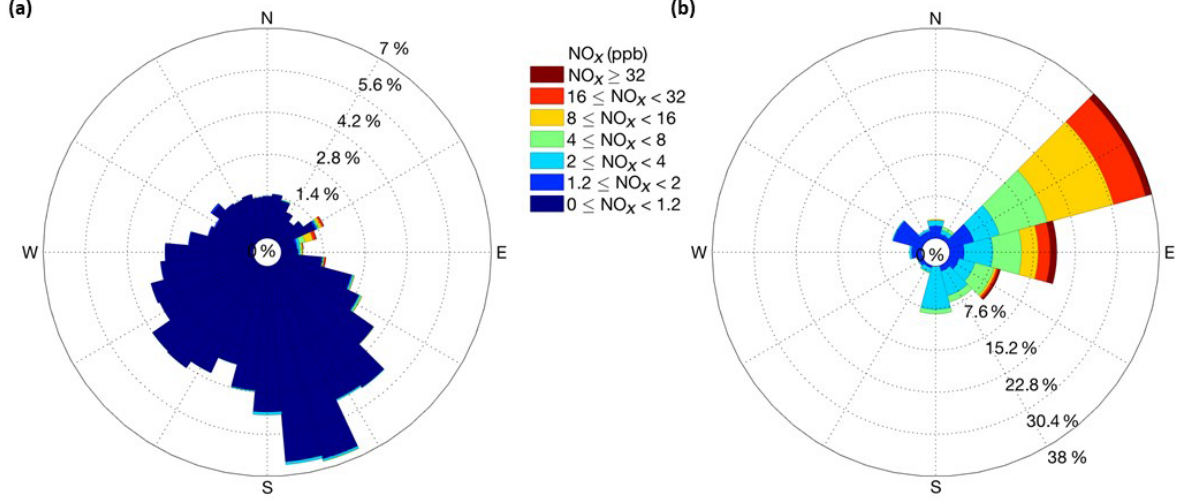
Figure 5. (a) Concentration wind rose with the relative frequency of NO x mixing ratio data from the above-surface inlets of the two snow towers segregated by 10 ◦ sectors for the full year of observation data. This panel shows all data. (b) The same analysis, with wind direction data binned in 20 ◦ sectors for events when NO x in ambient air exceeded 1.2ppb.